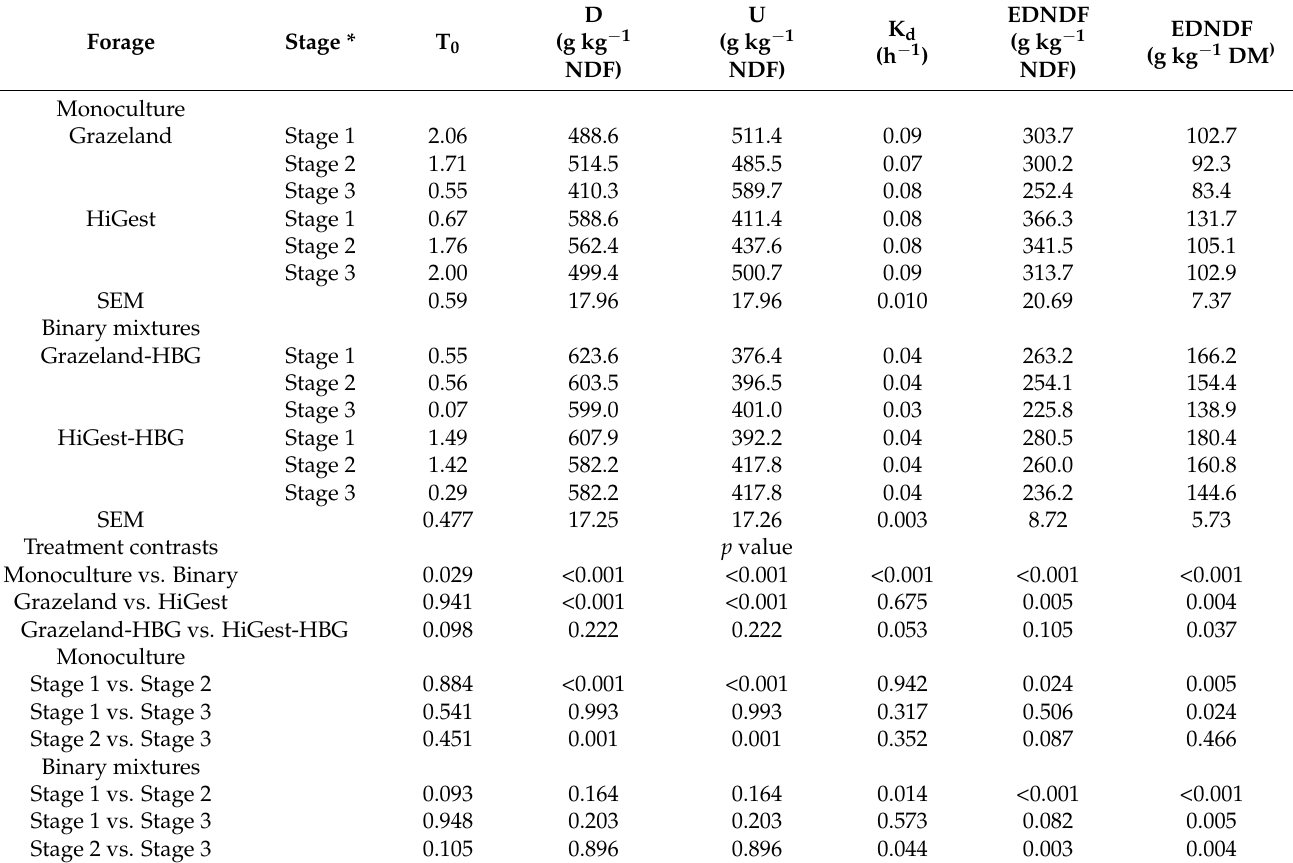
Table 6. Effects of cultivar, maturity, and their interaction on in situ rumen degradation kinetics of neutral detergent fiber (NDF) of alfalfa cultivars in monoculture and in binary mixtures with AC Success hybrid bromegrass (HBG) in Saskatoon, Saskatchewan